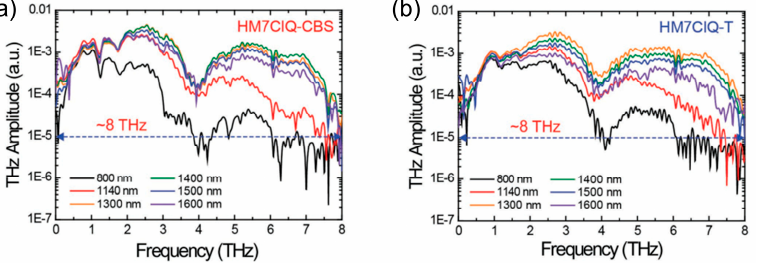
Figure 22. THz amplitude spectra generated in ( a ) 0.16 mm thick HM7ClQ-CBS and ( b ) 0.07 mm thick HM7ClQ-T crystals at different pump wavelengths [42].